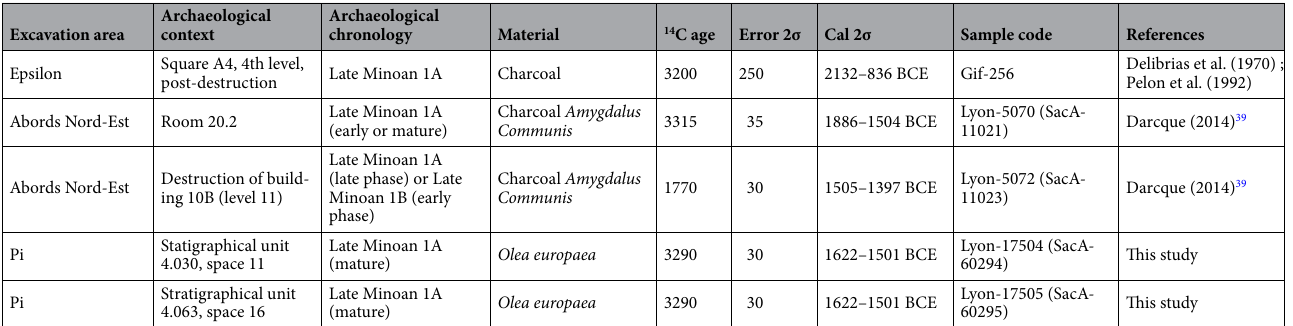
Table 2. Available radiocarbon dates of samples from the archaeological layers attributed to the LM-1A phase in